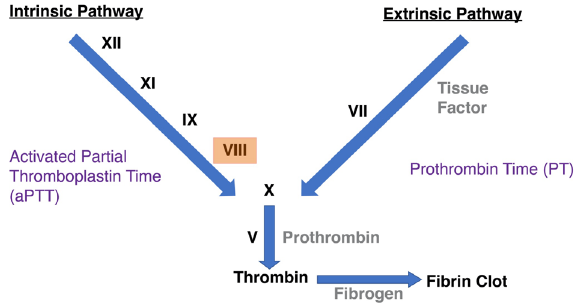
Figure 1. The human blood clotting cascade. The clotting cascade of human blood plasma follows two prominent pathways; intrinsic, measured by Activated Partial Thromboplastin Time (aPTT) and extrinsic, measured by Prothrombin Time (PT). To activate the intrinsic pathway, Human Blood Clotting Factor XII (FXII) acts as the first protein in a cascade of clotting factor activation. FXII activates FXI which activates FIX which finally activates FVIII. FVIII subsequently binds to and activates FX. To activate the extrinsic pathway, FVII forms a complex with Tissue Factor, activating FX. After activation of FX, both coagulation pathways converge. FX forms a complex with FV, converting prothrombin into thrombin. Thrombin then converts fibrinogen into fibrin, in turn creating a fibrin clot. Human plasma deficient in Factor VIII (highlighted in